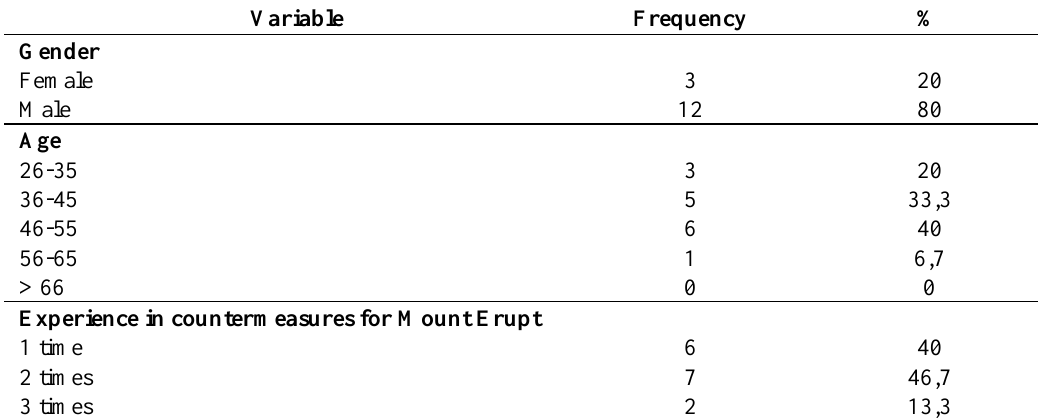
Table 1 The participants’ demographic data (n=15)